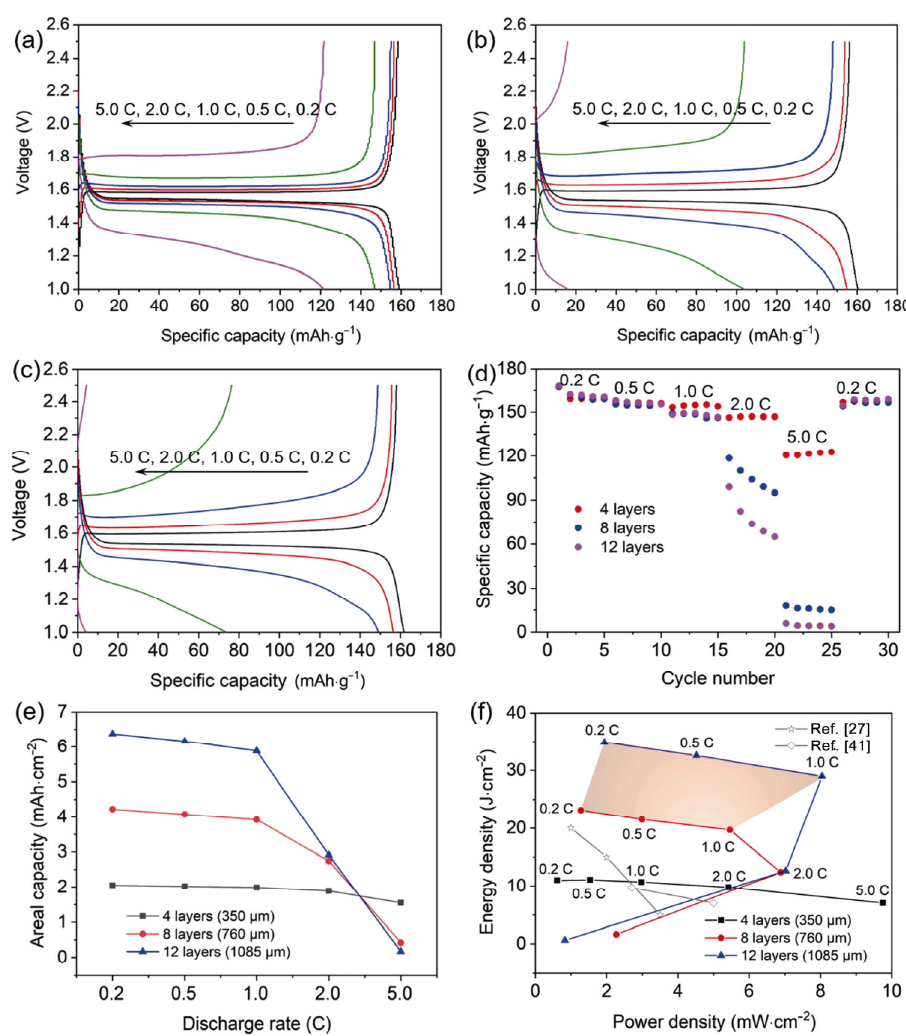
Fig. 6 Charge/discharge curves and rate capacities of electrodes with different thickness: (a) charge/discharge curves of electrodes with 4 layers, (b) charge/discharge curves of electrodes with 8 layers, (c) charge/discharge curves of electrodes with 12 layers, (d) rate performance, (e) areal capacity variation with discharge rate, and (f) Ragone plot of power density and energy